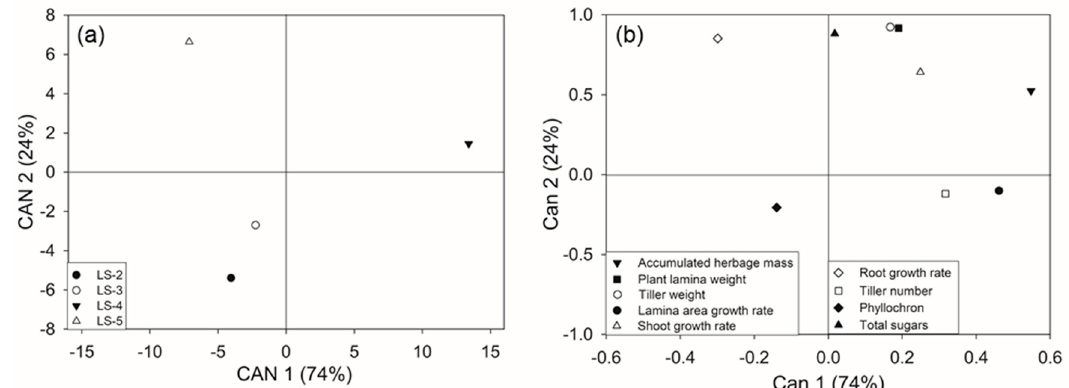
Figure 6. ( a ) Differences between each defoliation frequency treatment. The defoliation frequencies were based on defoliation at leaf stage 2 (LS-2; full circle); leaf stage 3 (LS-3; empty circle); leaf stage 4 (LS-4; full triangle); leaf stage 5 (LS-5; empty triangle). ( b ) Canonical variates showing the effect of defoliation frequency based on the plant leaf stage development for B. valdivianus evaluated through plant growth and physiological parameters.